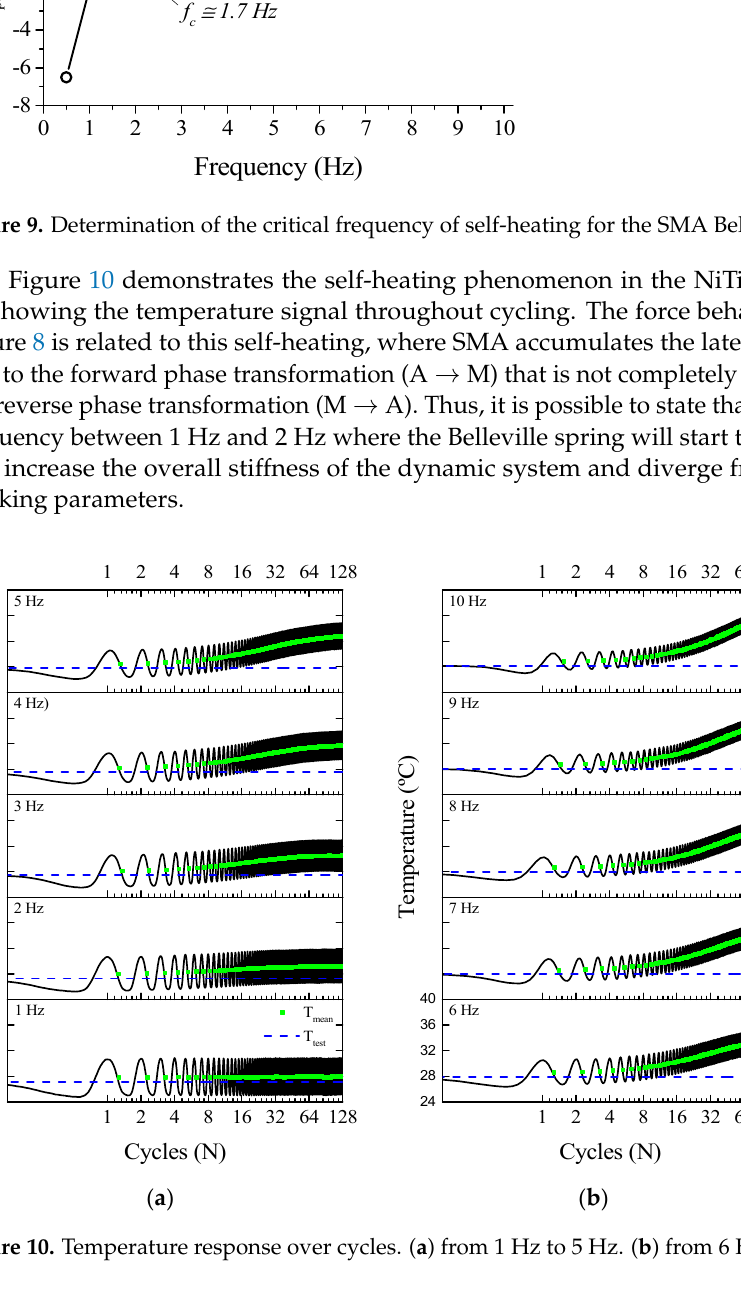
Figure 9. Determination of the critical frequency of self-heating for the SMA Belleville spring.